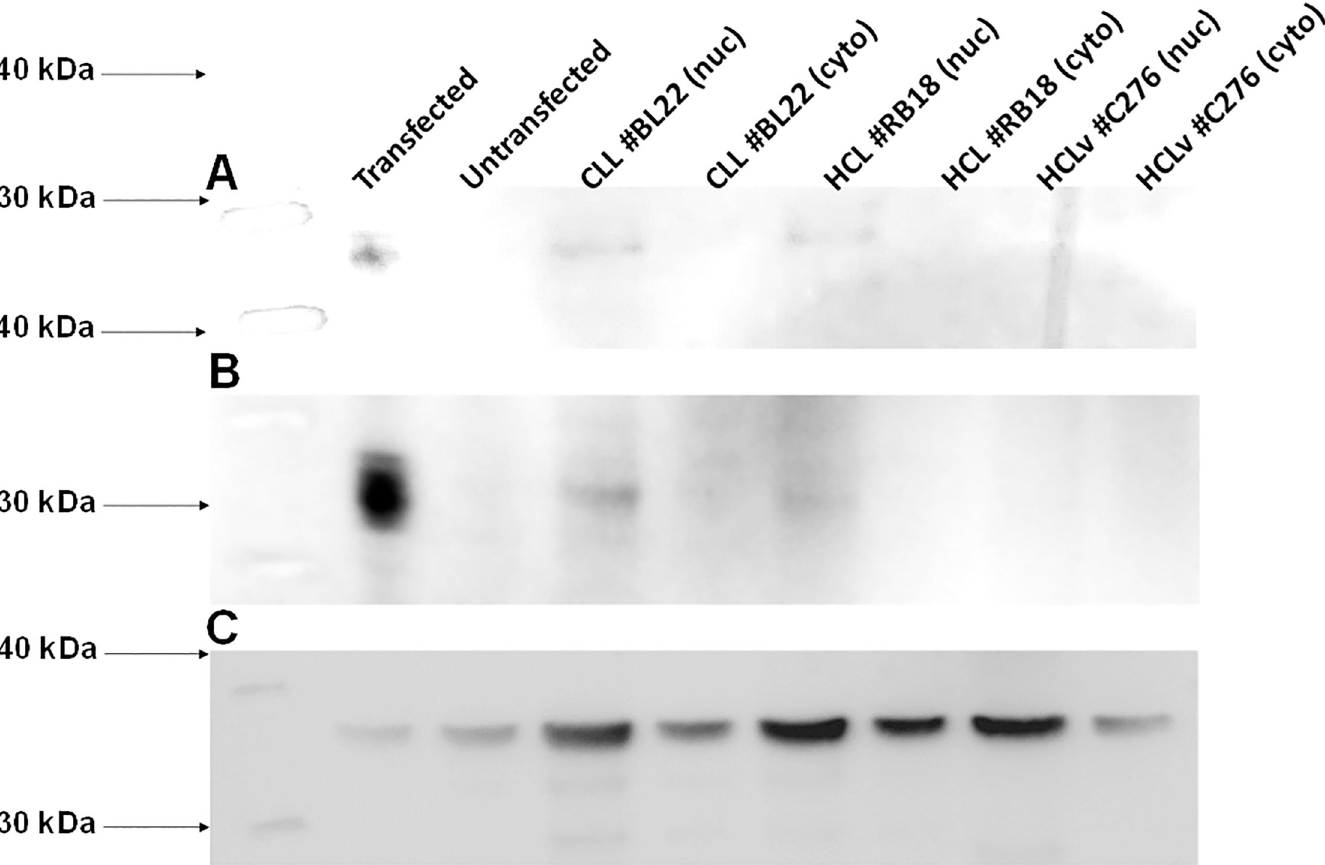
Fig 4. Western blot for Myf6 protein in HCL and CLL cells. Nylon + (A) and PVDF (B) membranes were stained with murine Mab SC-514379 followed by anti- mouse-HRP. In C, PVDF was stained with polyclonal anti-GAPDH antibody followed by anti-mouse-HRP. Lanes include Myf6-transfected (lane 1) and untransfected (lane 2) 293 cells, nuclear and cytoplasmic fractions for CLL patient BL22 (lanes 3 & 4, respectively), HCL patient BL18 (lanes 5 & 6), and HCLv patient C276 (lanes 7 & 8). In each lane, 30 ug of total protein was added, except less in A lane 1 to obtain bands of similar intensity.